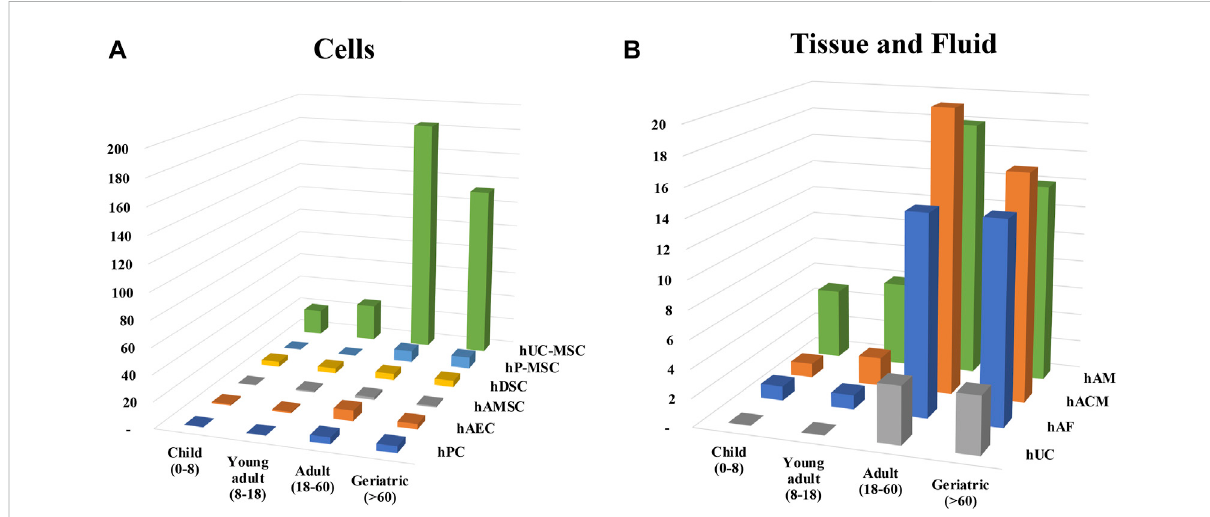
FIGURE 6 Distribution of clinical trials according to age groups. Clinical trials were classi fi ed in (A) cells or (B) tissue and fl uid and the different age group wereassigned.Patientsweredividedandnamedinfourgroupsdependingontherangeofage:children(0 – 8 years),youngadults(8 – 18 years),adult (18 – 60 years) and geriatric (60 and